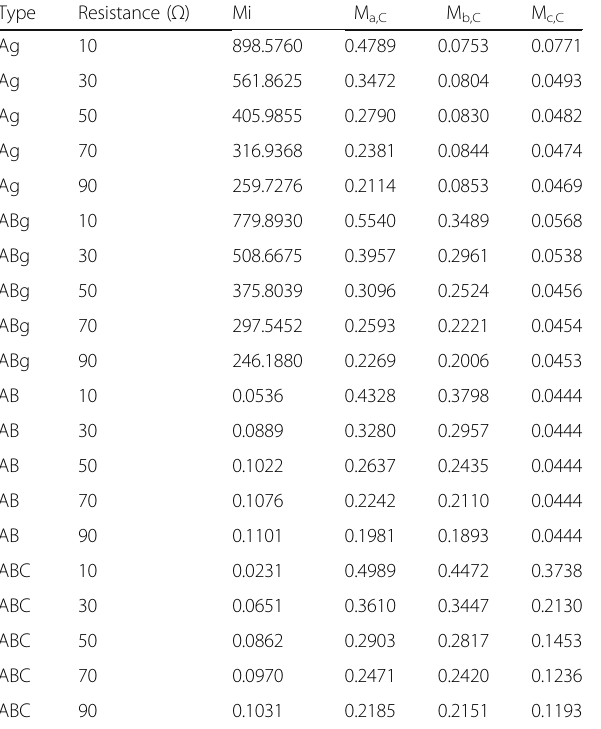
Table 3 Results of various fault resistances Type Resistance ( Ω )